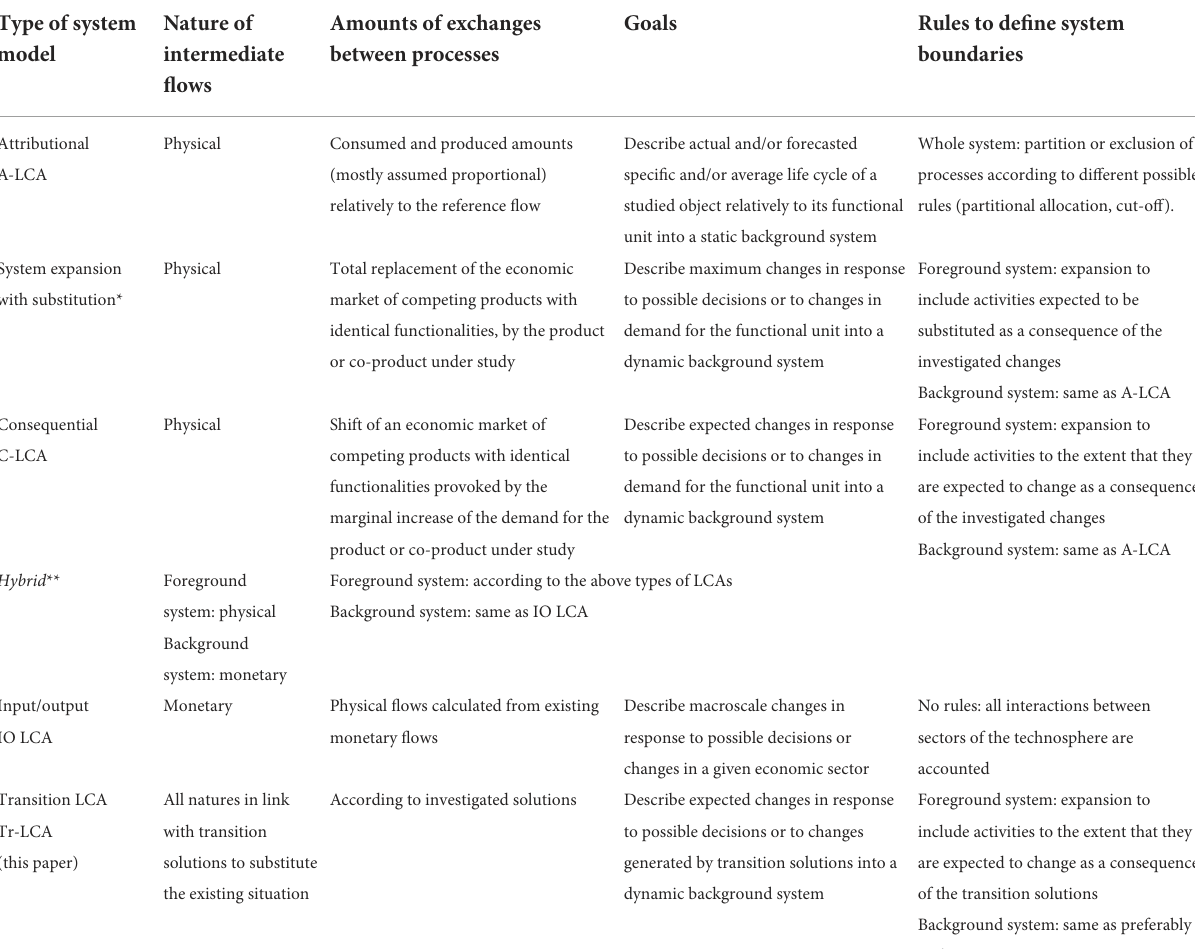
TABLE 2 Synthesis of modeling structures of